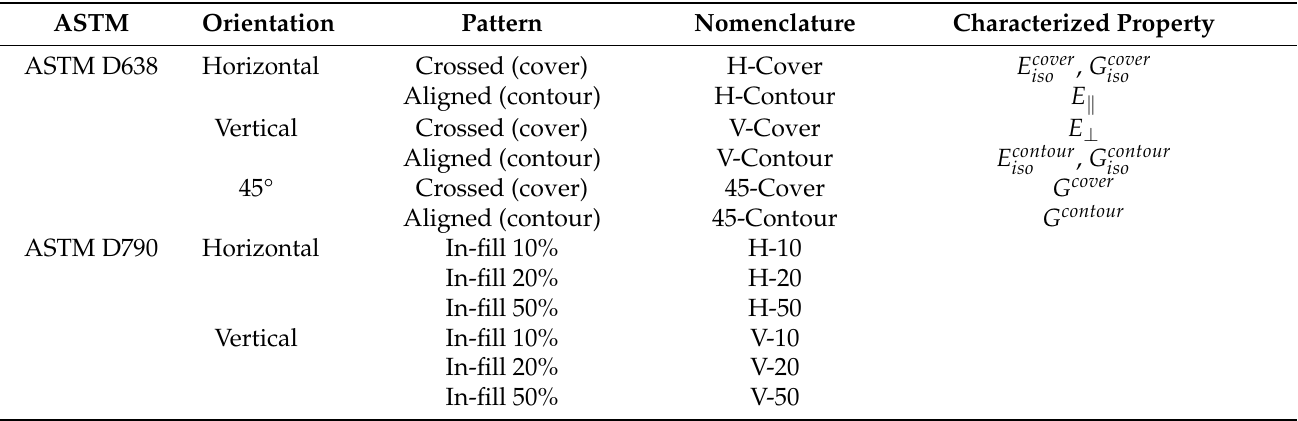
Figure 11. Non-dimensional relationships for PLA, ABS/GP, and ABS/PC referred to E (cid:107) . ( a ) Cover zone. ( b ) Contour zone. Table 6. Experiment set